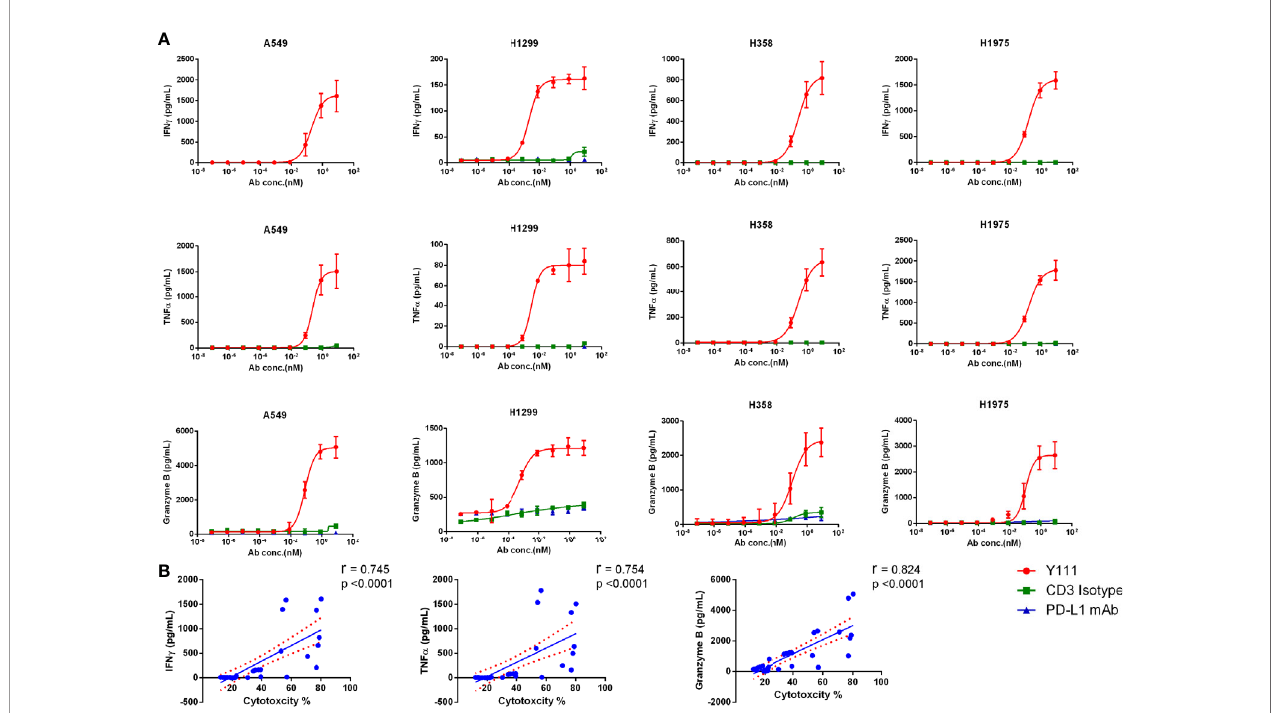
FIGURE 6 | Y111 prompted the release of IFN g , TNF a , and granzyme B from V g 2V d 2 T cells. (A) The increased cytokine secretion by V g 2V d 2 T cells after co- culture for 12 h with tumor cells with Y111 or control antibodies (as indicated in Figure 4 ) analyzed by the CBA method. Please note that the values were the results of raw values subtracted E+T only groups. The data points in Figure 5 were represented as mean ± SEM among 9 healthy subjects. (B) The correlations of the enhanced cytotoxicity induced by Y111 with the increased production of IFN g , TNF a , and granzyme (B) The spearman ’ s r and two-tailed p values were calculated by GraphPad prism 6. The blue line indicated the best- fi t line, and the red line indicated the 95% con fi dence band of the best- fi t